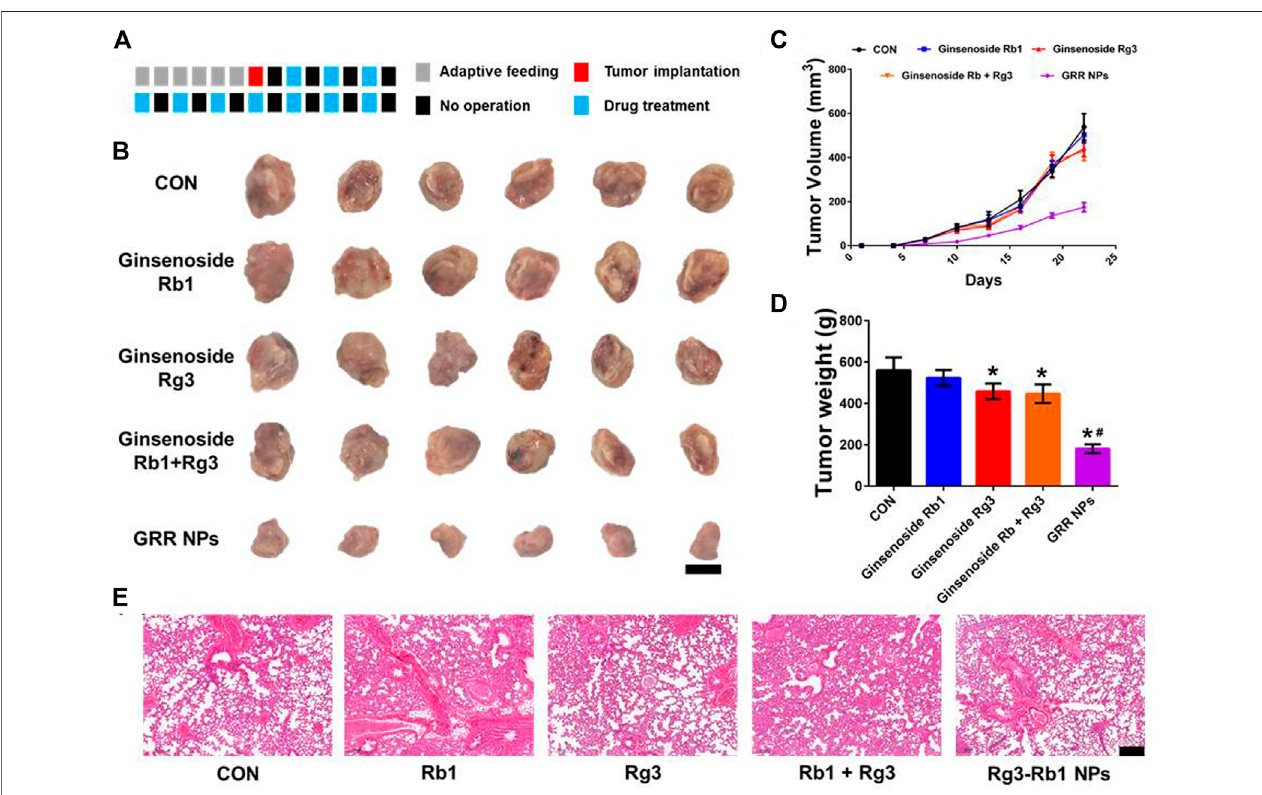
FIGURE 4 | In vivo pharmacological effect of Rg3-Rb1 NPs. (A) The dosage regimen for treating the 4T1 orthotopic mammary mouse model, each square represents 1 day, (B) tumor images, (C) tumor volume, and (D) tumor weight. Scale bar = 1 cm. p p < 0.05 compared with the control group. # p < 0.05 compared with the Rg3 group. (E) Lung images of 4T1 orthotopic mammary mouse. Scale bar = 2 mm. NPs, nanoparticles.